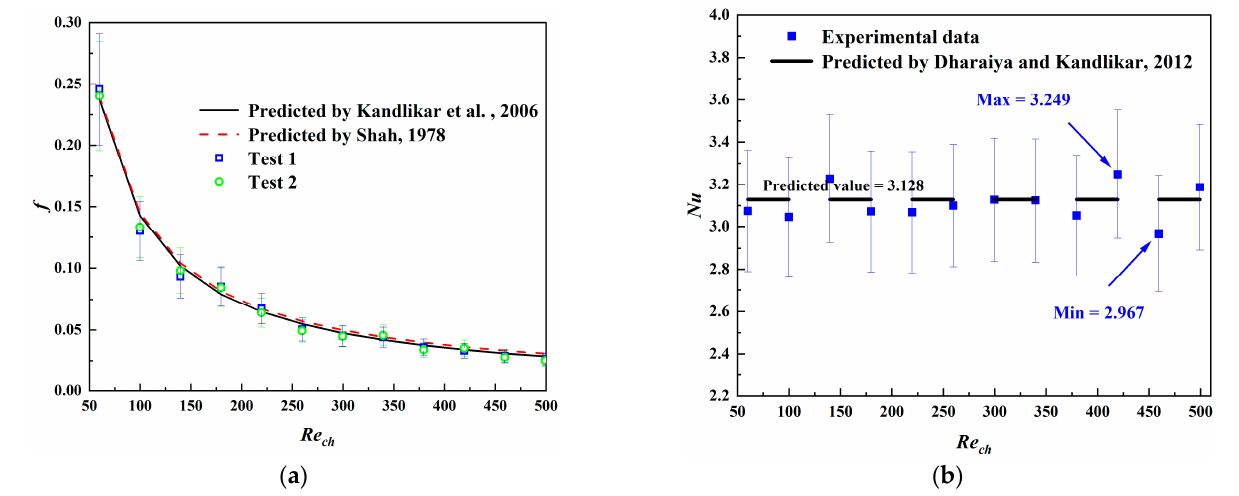
Figure 8. Validation study of single-phase flow in the continuous heat sink without membrane: ( a ) Friction factor [36,39]; ( b ) Nusselt number